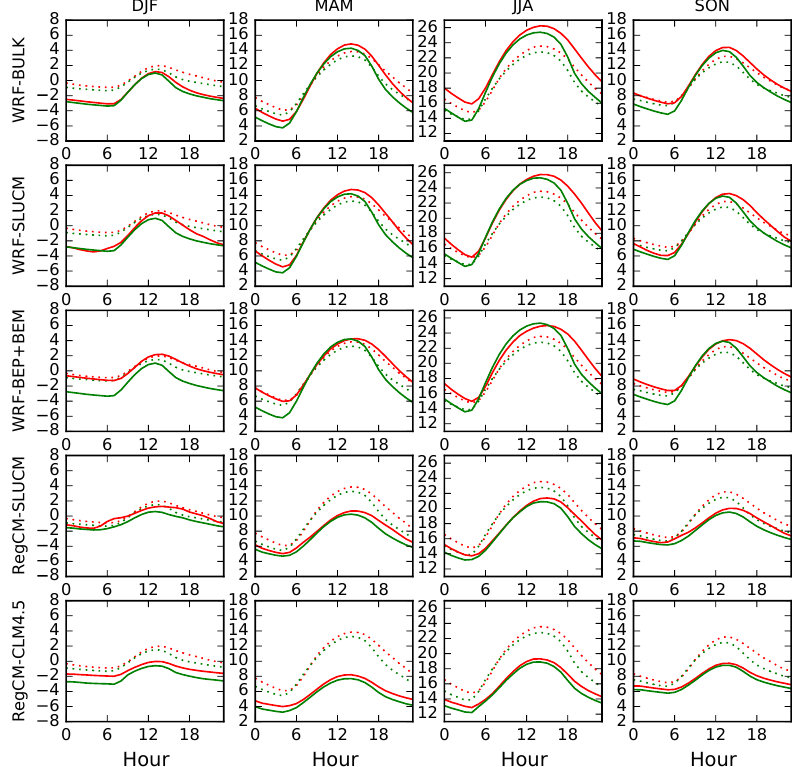
Figure 6. Averaged daily temperature cycles ( ◦ C) in the Prague city centre (station Karlov, red) and its surroundings (station Ruzynˇe, green). The comparison shown is of modelled (solid) and measured values (dotted). The time axis corresponds to